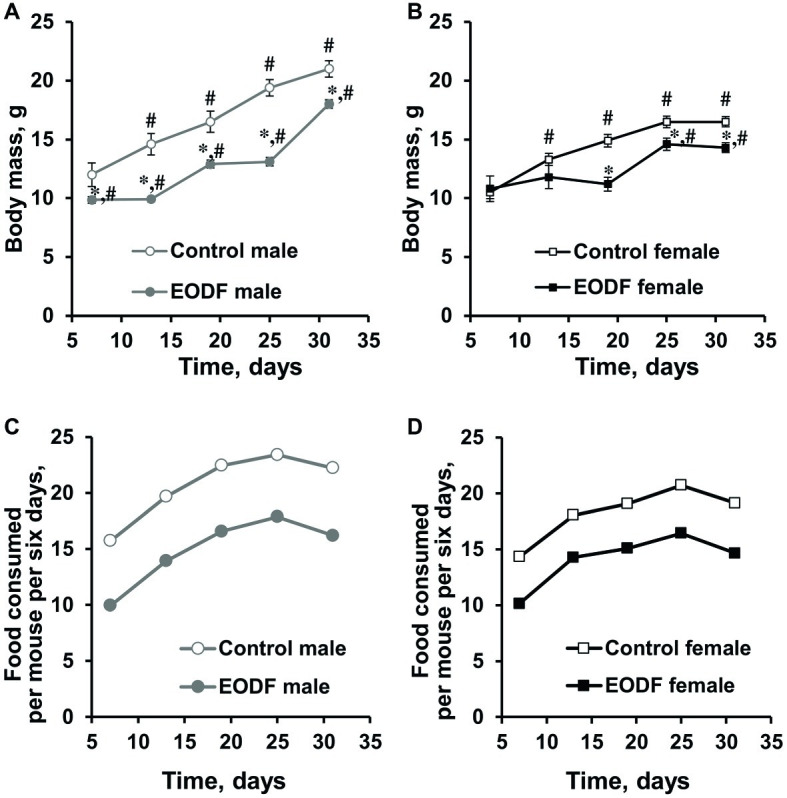
Body mass of male (A) and female (B) mice fed ad libitum (control, n = 6 males, n = 6 females) or subjected to an every-other-day feeding regimen (EODF, n = 7 males, n = 6 females) and the cumulative amount of food consumed per mouse for 6 days over 1 month by males (C) and females (D). Data gathered every 6 days starting from 7th day. (A,B) Data are presented as mean ± S.E.M. from six to seven mice. (C,D) For each group, there was one cage with six to seven mice. Amount of food consumed by a group of mice in each cage was estimated each 6 days and calculated per mouse. Cumulative food consumption was calculated by summarizing data at previous and current time points. *Significantly different from the corresponding control group (p < 0.05), Welch’s t test, #significantly different from initial weight of corresponding group (p < 0.05), Dunnett’s test after one-way ANOVA.